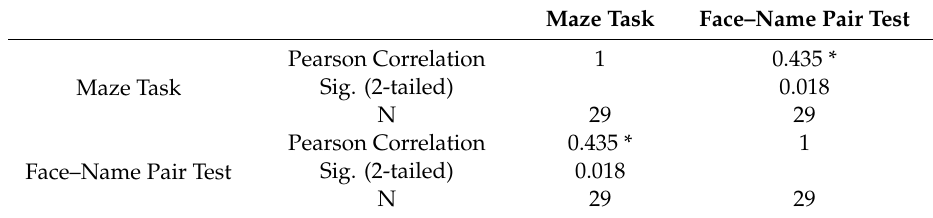
Figure 12. Comparison of memory measurements between the maze task and the face–name pair test in autonomous mode. Table 3. Correlation between the response accuracy of both the maze task and the face–name pair test (autonomous